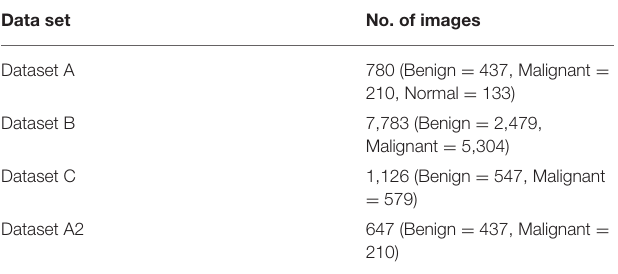
TABLE 3 | Dataset parameters.